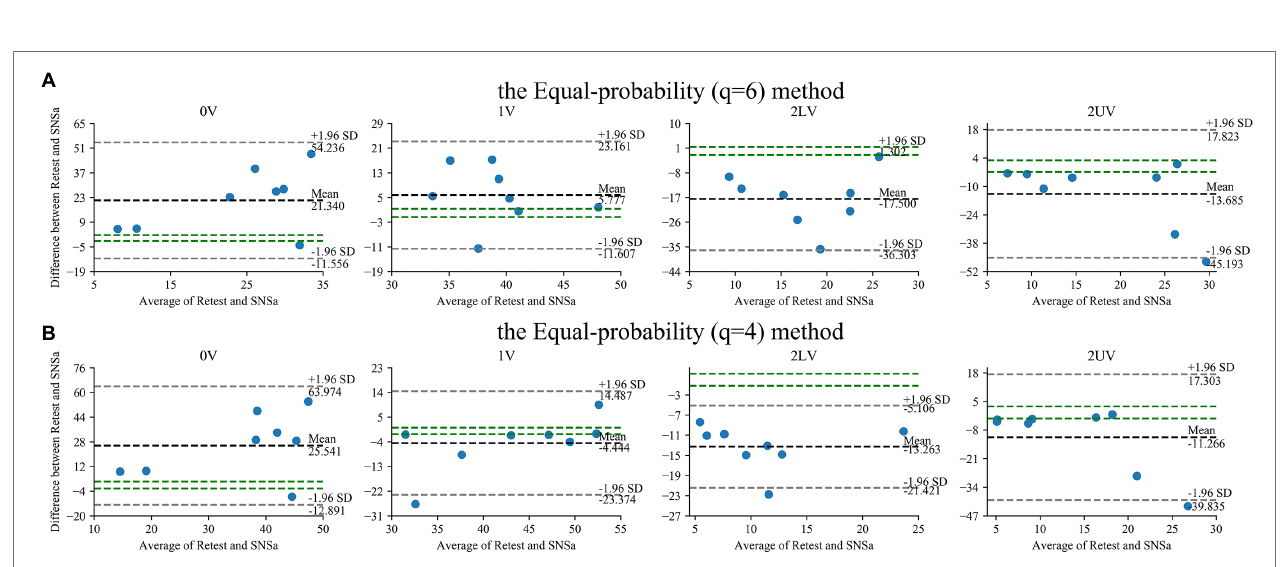
FIGURE 4 | Bland–Altman plots for SymDyn indices 0V, 1V, 2LV, and 2UV (Retest and sympathetic nervous system activity—SNSa stimulation): (A) the Max–min method, (B) the σ -method. The black dashed line indicates the mean difference, the grey dashed lines are the limits of agreement (±1.96 SD), and the green lines are the maximum allowed difference.